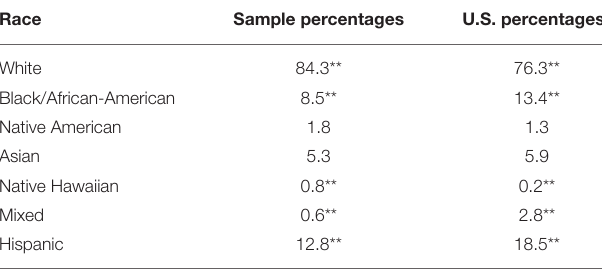
TABLE 3 | Comparisons of sample and U.S. racial